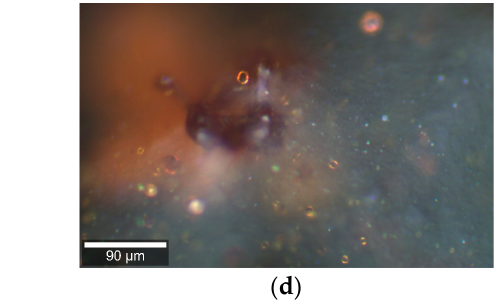
( d ), respectively) containing curcumin before and after the irradiation in the absence of nail, where